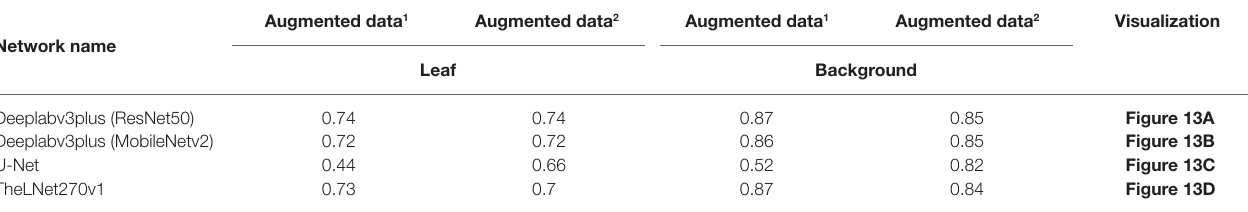
TABLE 10 | The mean IoU for comparative analysis.